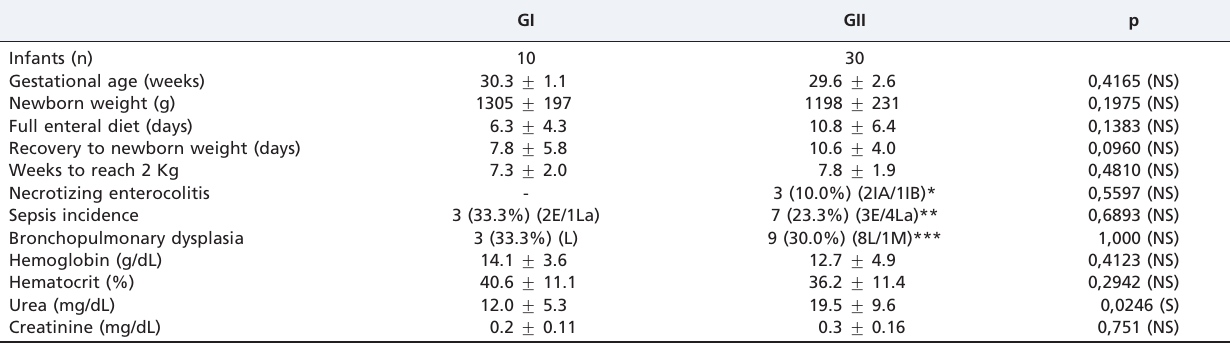
Table 1 - Group I and Group II studied cases in regards to weight, enteral progression and clinical - laboratory data. GI